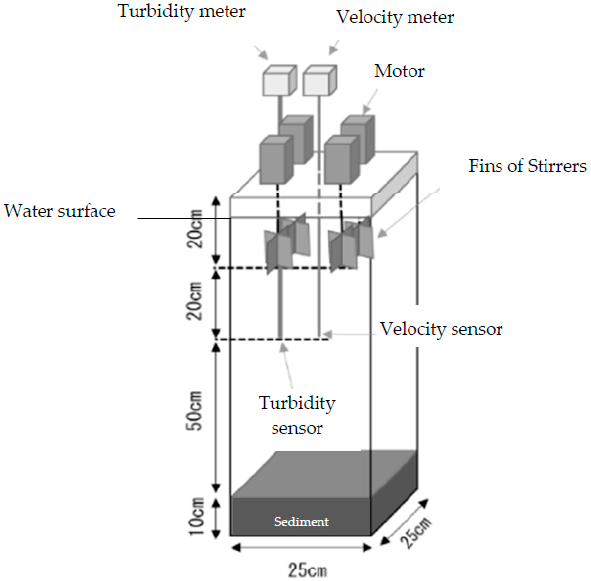
Figure 9. Experimental setup of sediment resuspension.